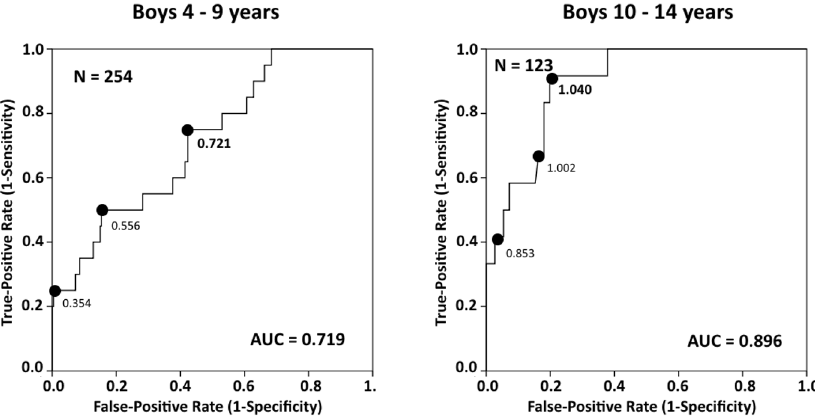
Fig 2. Receiveroperating characteristic (ROC) curves for identifying sarcopenic obesity according to different cut points for grip-to-BMI (kg/kg) in boys.